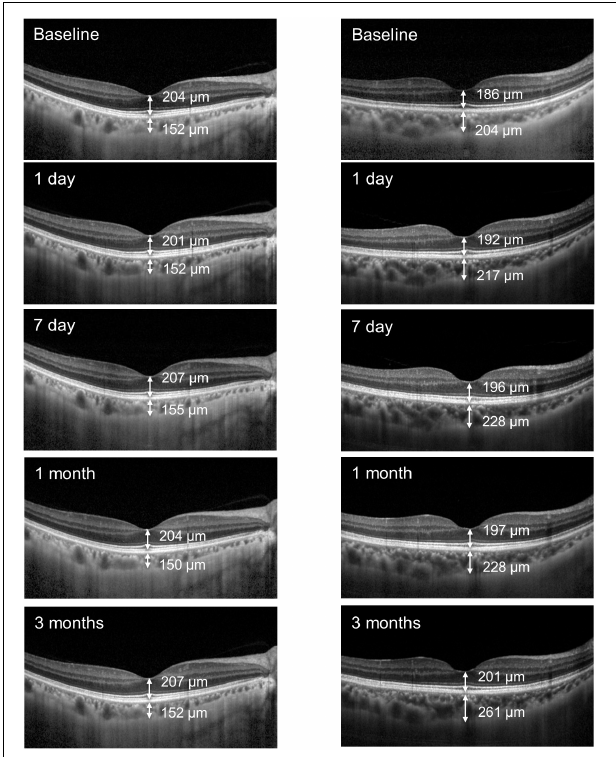
FIGURE 2 | Two representative cases illustrating the choroidal thickness and retinal thickness measurements before and after FLACS (left) and CPS (right) surgery.